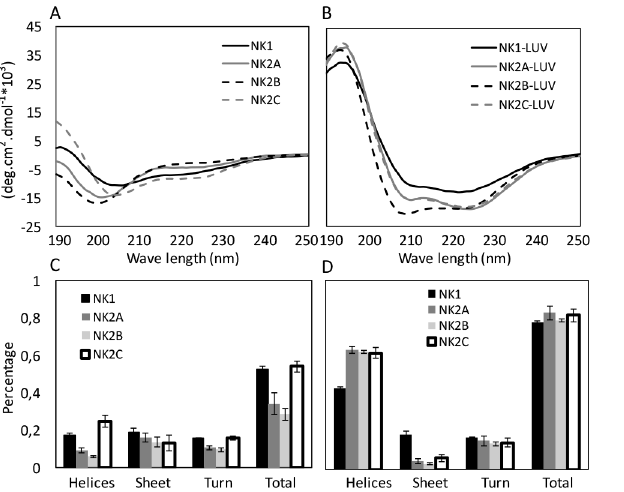
Fig 2. Secondary structural changes of the four synthetic bovine NK-lysin peptides upon liposome binding. CD spectra of NK-lysin peptides in lipid-free (A) and lipid-bound states (B) are compared. Estimated secondary structural contents, including alpha-helices, beta-sheet, beta-turn and the total secondary structure in lipid-free and lipid-bound states are shown in (C) and (D), respectively.